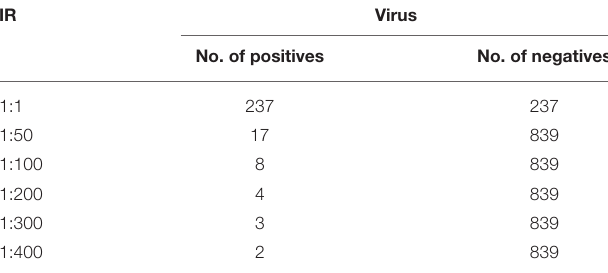
TABLE 3 | The number of positive and negative samples for different IRs for virus. IR